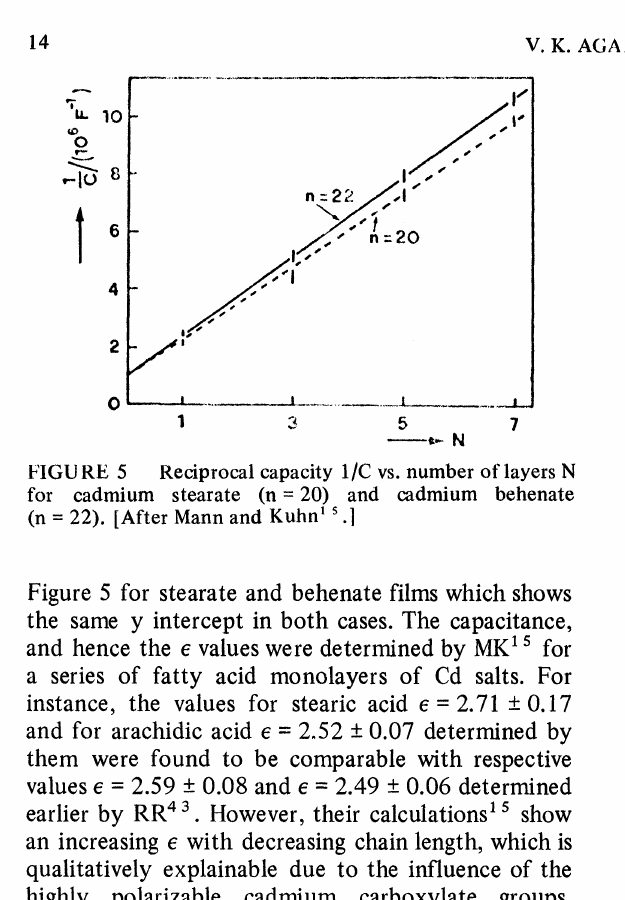
,5 7 N FIGU RE 5 Redprocal capacity 1/C vs. number of layers N for cadmium stearate (n 20) and cadmium behenate (n 22). [After Mann and Kuhn s.]